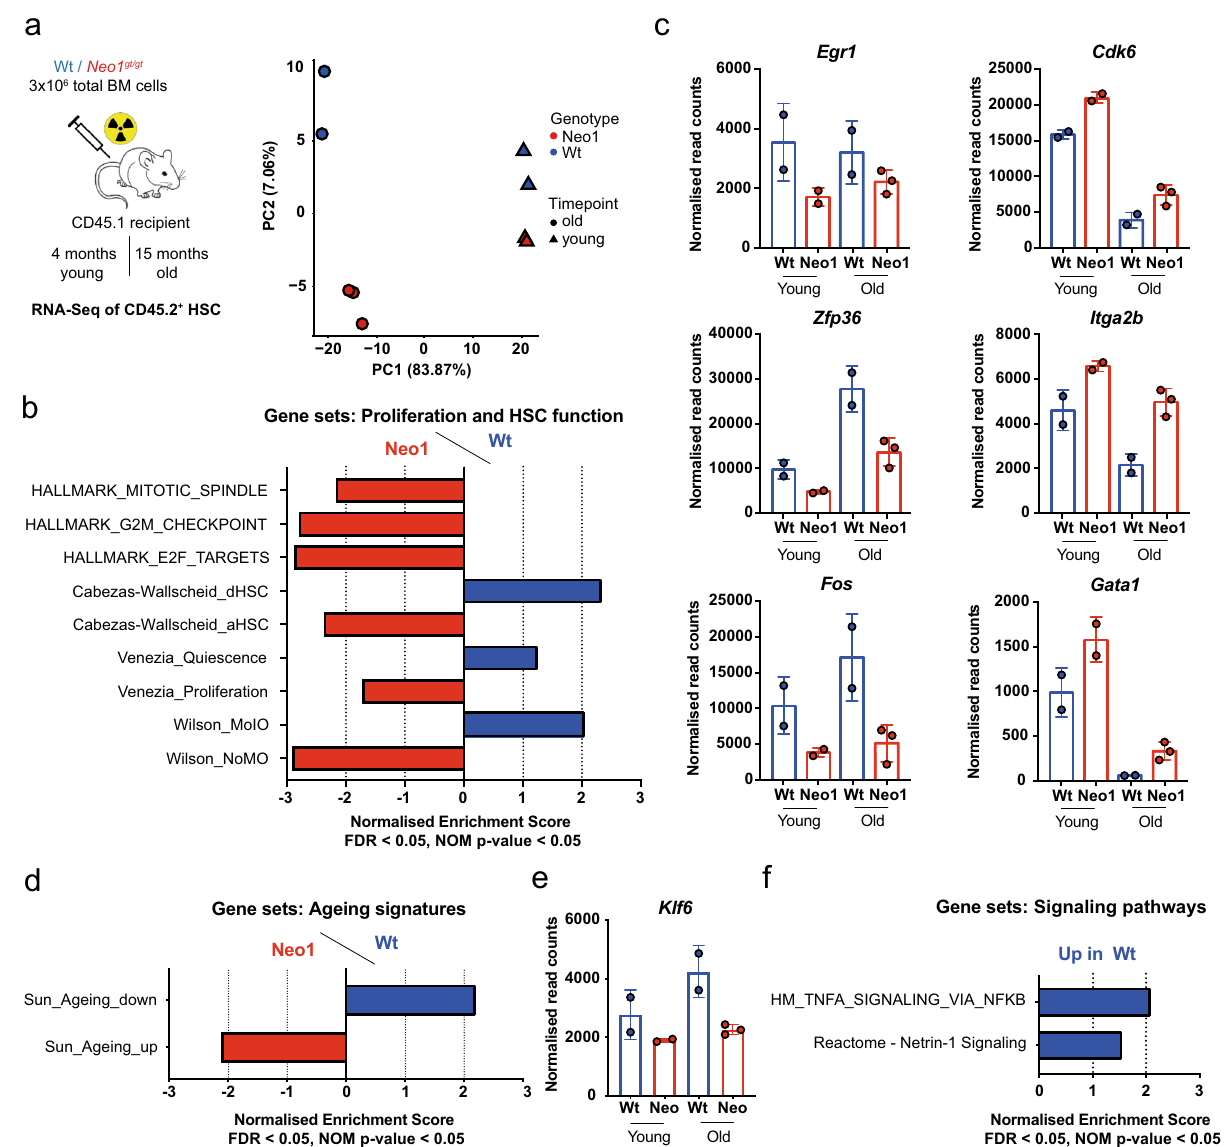
Fig. 4 Neo1-mutant HSCs reveal a loss of quiescence and potency signatures. a , Left: work fl ow for RNA-seq of CD45.2 + HSCs from Wt and Neo1 gt//gt chimeras after 4 and 15 months. Right: sparse PCA; n = 2 (WT old/young, Neo1 young) – 3 (Neo1 old). b GSEA for cell cycle and HSC potency of Wt vs. Neo1 gt//gt HSCs. FDR < 0.05, NOM p value <0.05. c Normalized read counts of DEG in HSCs from young and old Wt and Neo1 gt//gt chimeras, n = 4 (Ctrl) – 5 (Neo1). d GSEA for HSC ageing signatures in Wt vs. Neo1 gt//gt HSCs. FDR < 0.05, NOM p value <0.05. e Normalized read counts of Klf6 in HSCs from young and old Wt and Neo1 gt//gt chimeras, n = 4 (Ctrl) – 5 (Neo1). f GSEA for signalling pathways in Wt vs. Neo1 gt//gt HSCs. FDR < 0.05, NOM p value <0.05 . For all panels, ±SD is shown. n indicates biological replicates. Scale bars in IF images are 4 μ m. P value was determined by two-tailed t test unless stated otherwise. Source data are provided as a Source Data fi